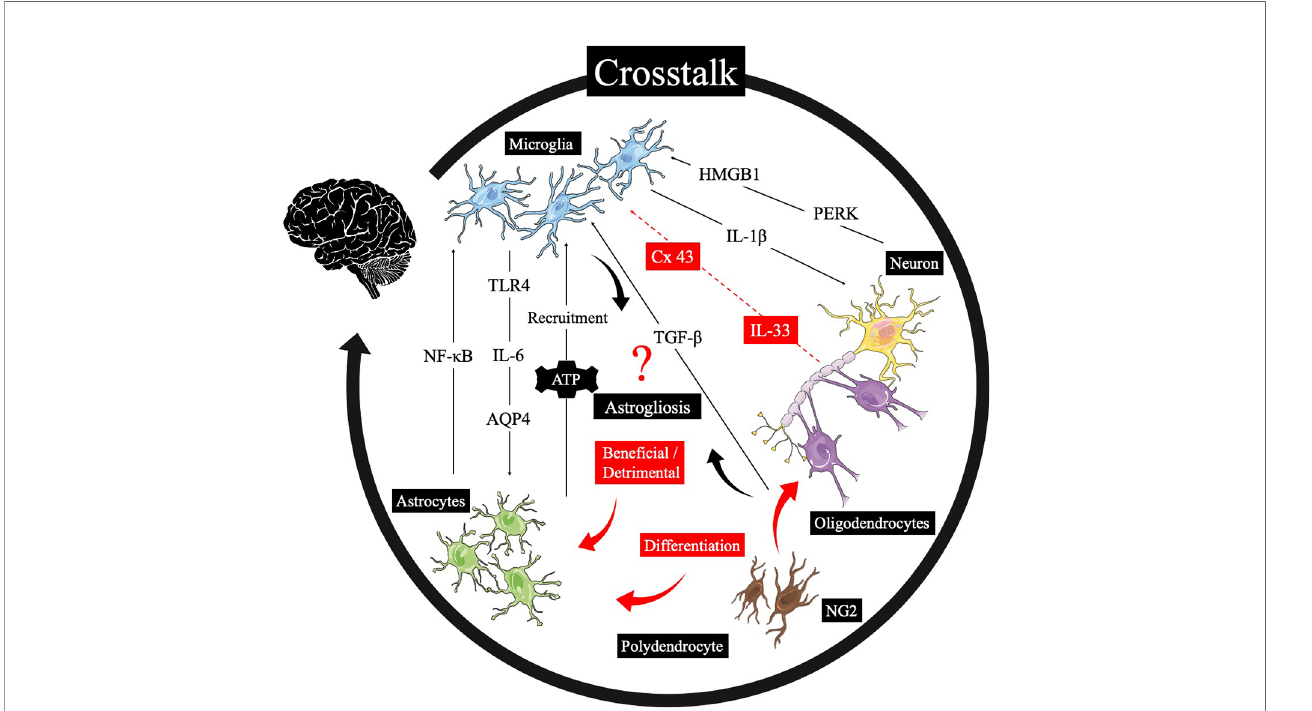
FIGURE 1 | The crosstalk of cells in the neuroin fl ammation. After TBI, the microglia can interact with astrocytes, the oligodendrocyte, neurons, and NG2 cells through several pathways, and the “ closed-loop ” mechanisms of their communications remain unclear. In addition, the differentiation between the NG2 cells and polydendrocytes or oligodendrocytes is still not clear, and their difference might play a role in neuroin fl ammation. (black color: settled cell – cell crosstalk mechanisms, red color: possible crosstalk mechanisms need to be certi fi